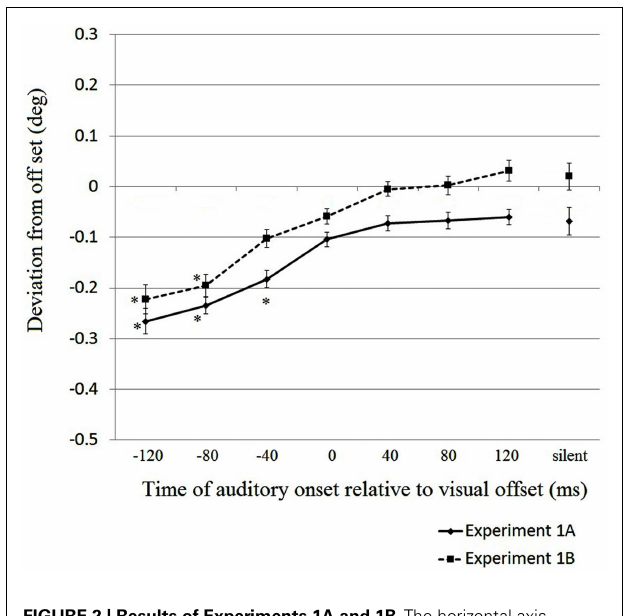
FIGURE 2 | Results of Experiments 1A and 1B. The horizontal axis represents the experimental conditions for different presentation timings of the auditory signal.The vertical axis represents the perceived deviation from the physical visual offset position in degrees of visual angle. A negative value in the deviation from offset ( Y -axis) means that the perceived visual offset position was behind the actual visual offset position. Error bars represent within-participants SEMs (Loftus and Masson, 1994; Cousineau, 2005) for each presentation. Data points with an * mark indicate that the perceived positions differ from